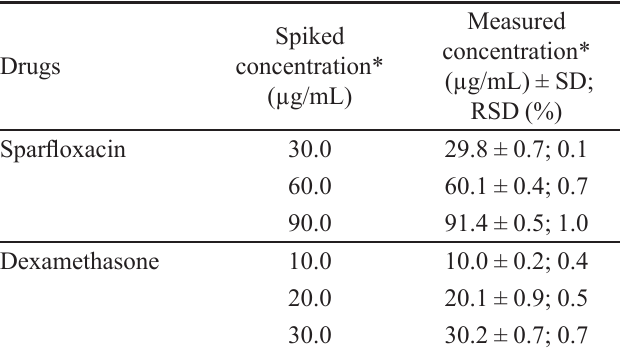
TABLE I - Accuracy of the Proposed HPLC Method